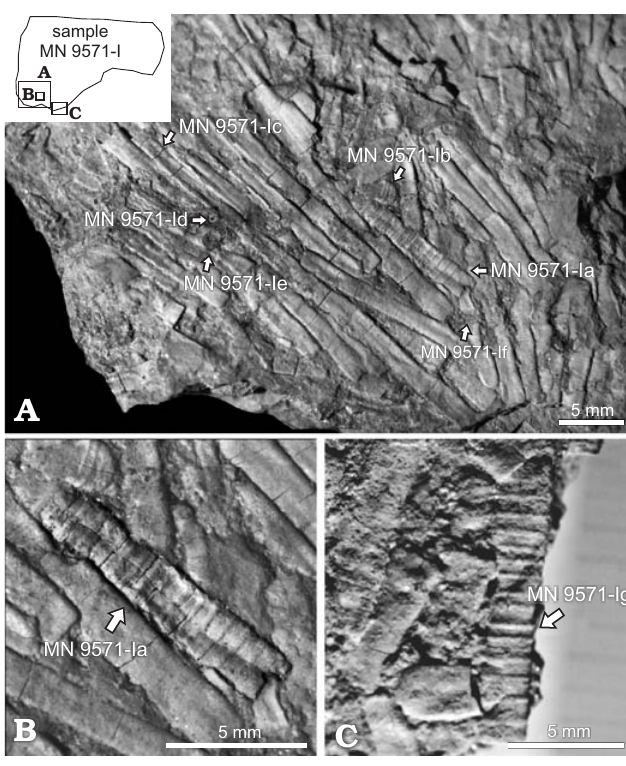
Fig. 1. Sample (MN 9571-I) from Rio Caniú outcrop, Brazil; Ponta Grossa Formation, Upper Emsian, Lower Devonian. A . Fragment showing numer- ous tubes; holotype of Annulitubus mutveii gen. et sp. nov. (MN 9571-Ia) and paratypes (MN 9571-Ib–e). Note that all tube fragments are straight and have similar orientation, some show smooth surfaces, with very subtle striae, in others it is possible to see shallow rings. B . Enlarged holotype (MN 9571-Ia), note the smooth rings. C . Fragment showing paratype (MN